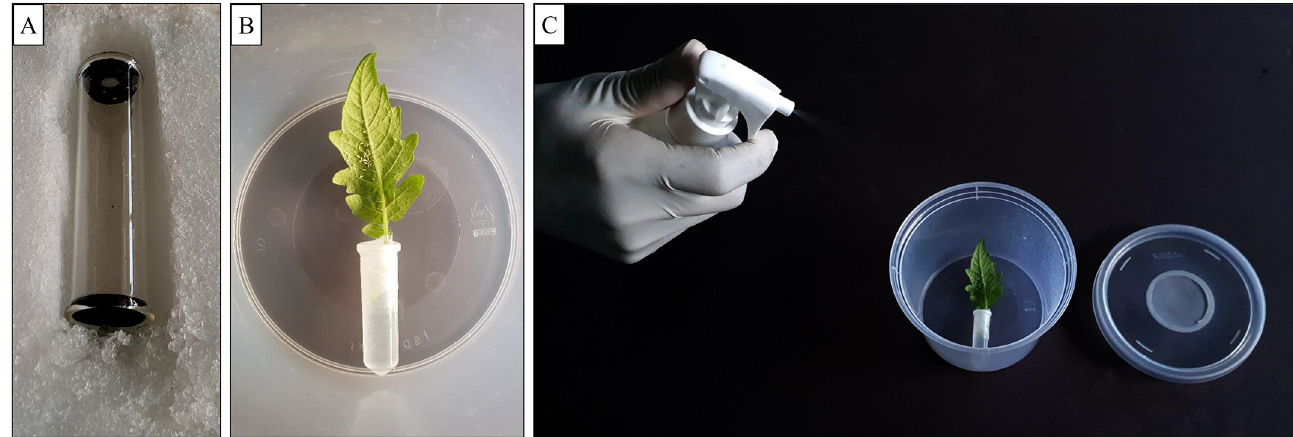
Fig 1. Experimental setup for the direct spray application of MB solutions onto the whitefly-infested tomato leaves. (A) Adults of Bemisia tabaci (less than 5 days old) from the rearing colony were collected in a group and placed on ice; (B) Batches of 25 cold-immobilized adults were placed on test leaves in breeding cups; (C) MB solutions were sprayed onto each leaf using a glass spray bottle.